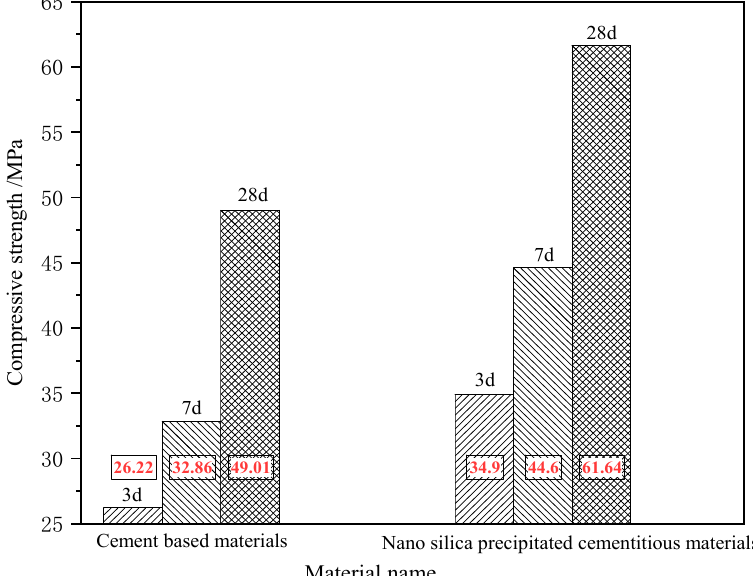
Figure 9. Effect of nano-SiO 2 precursor solution on the compressive strength of cement-based materials.